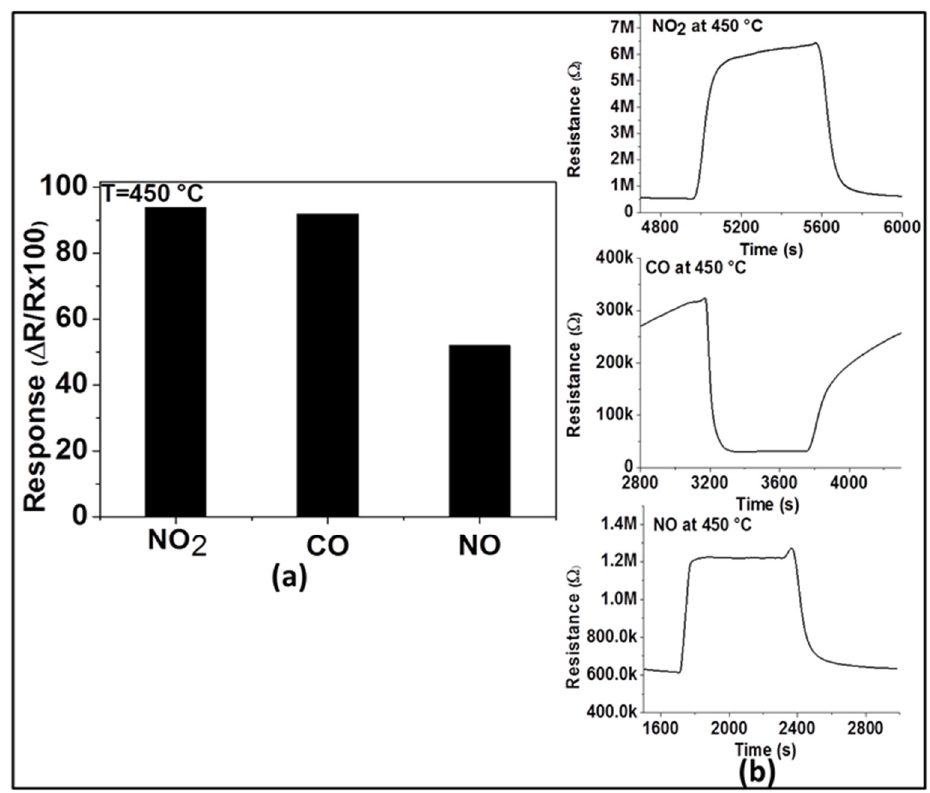
Figure 6. Response of gas sensor based on ZnO thin film to various gases including 200 ppm of NO 2 , CO, and NO at 450 °C ( a ) and their dynamic responses ( b ).